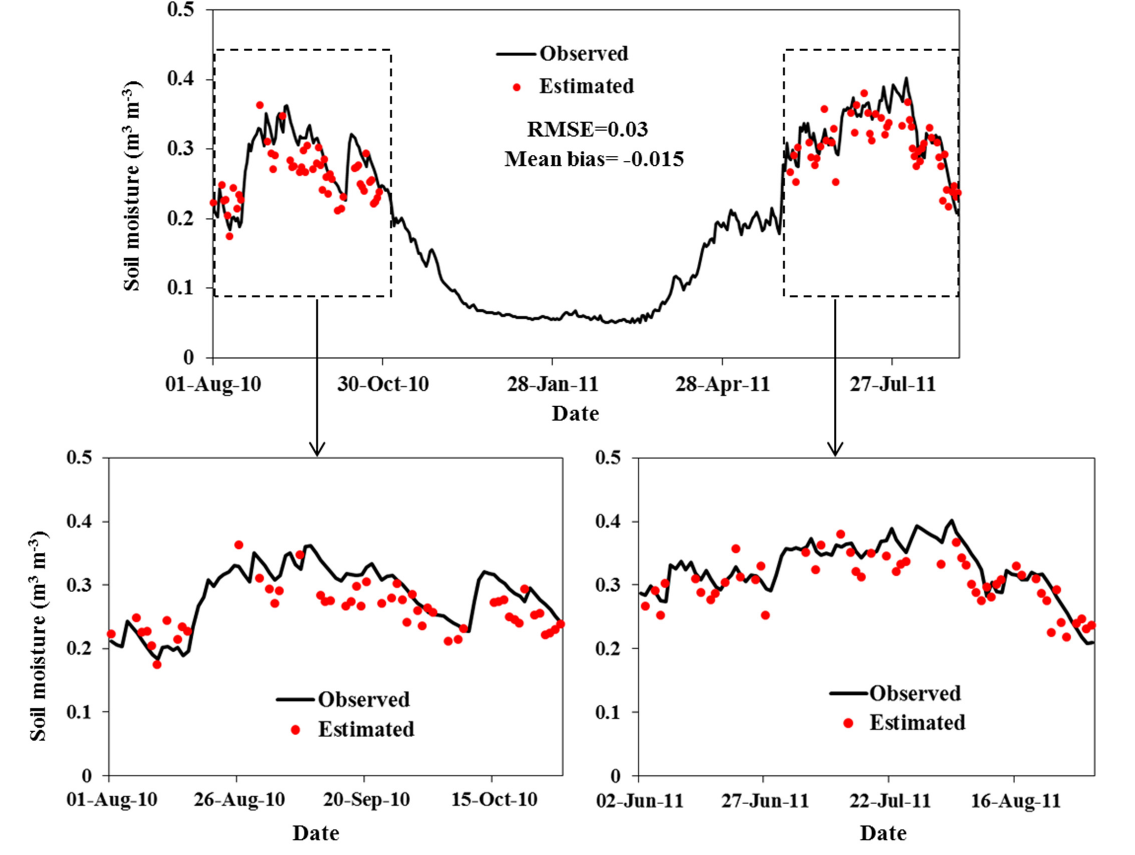
Figure 5. Comparison of daily station-averaged surface soil moisture with observed ones. Only days with MODIS data available at more than 13 sites are